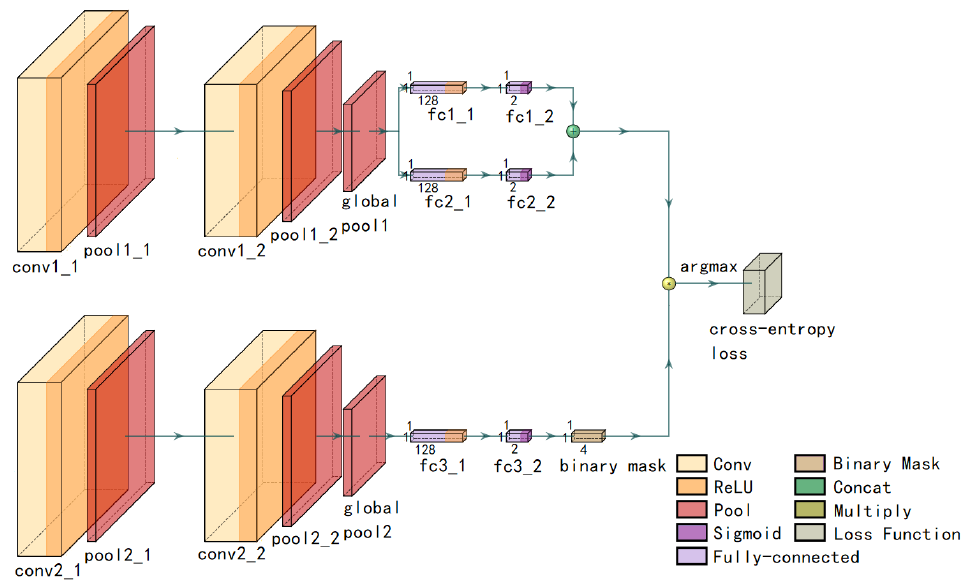
Figure 4. Structure of mask multi-head convolutional neural network (MM-CNN).